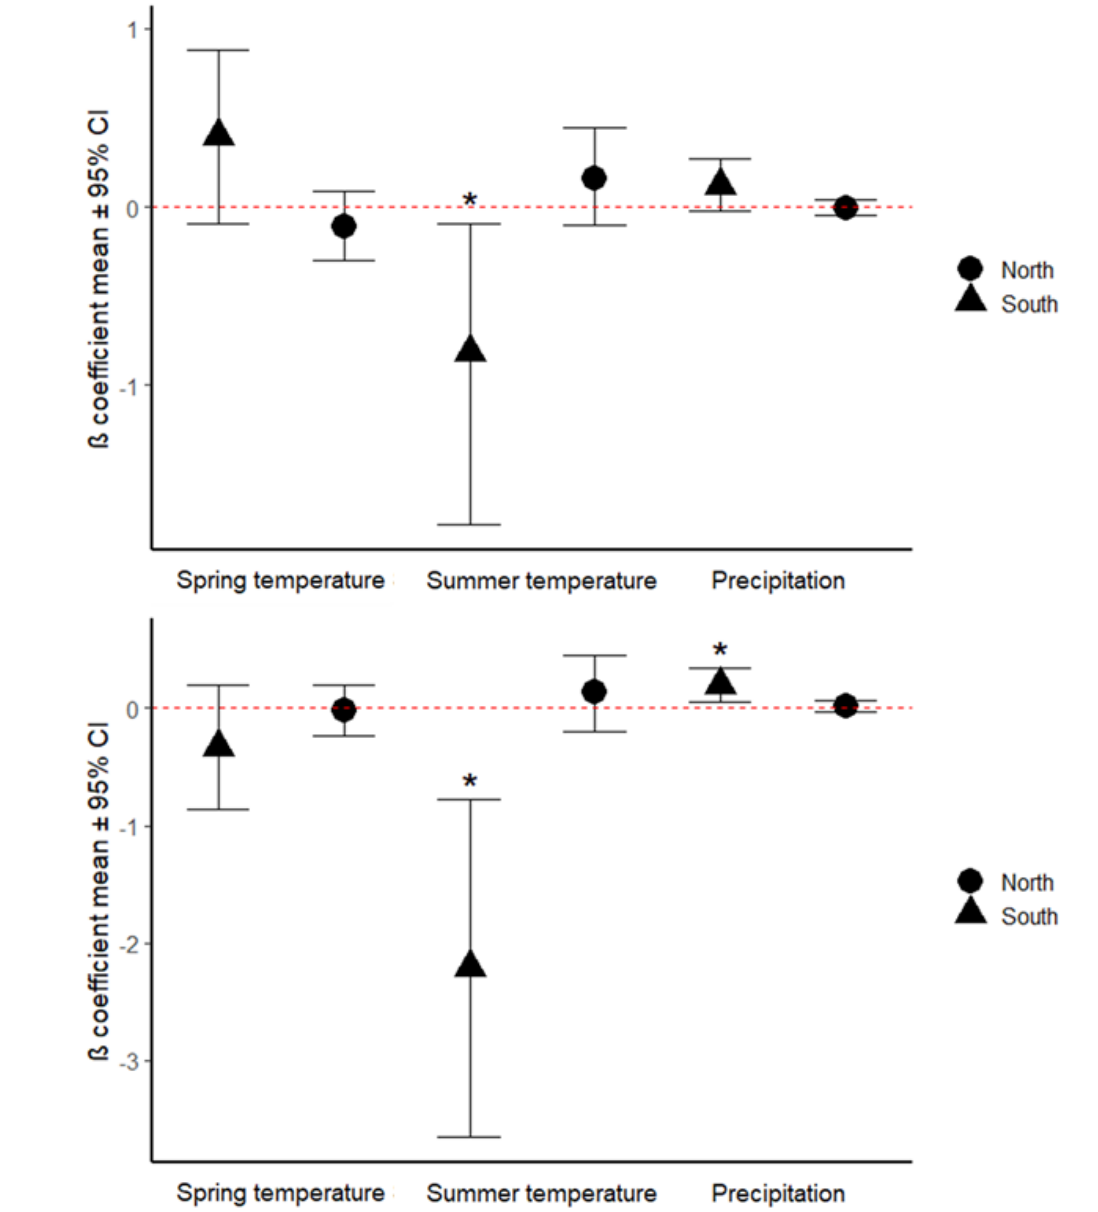
Figure 2. Parameter estimates (mean ± 95% CI) showing the effects of spring temperature (April for south and May for north), summer temperature (June for south and July for north) and summer precipitation (July for southern sites, August for northern sites) on the growth of ( a ) Acer rubrum and ( b ) Acer saccharum . Parameters were standardized by multiplying each one by the covariate mean. * outlier.